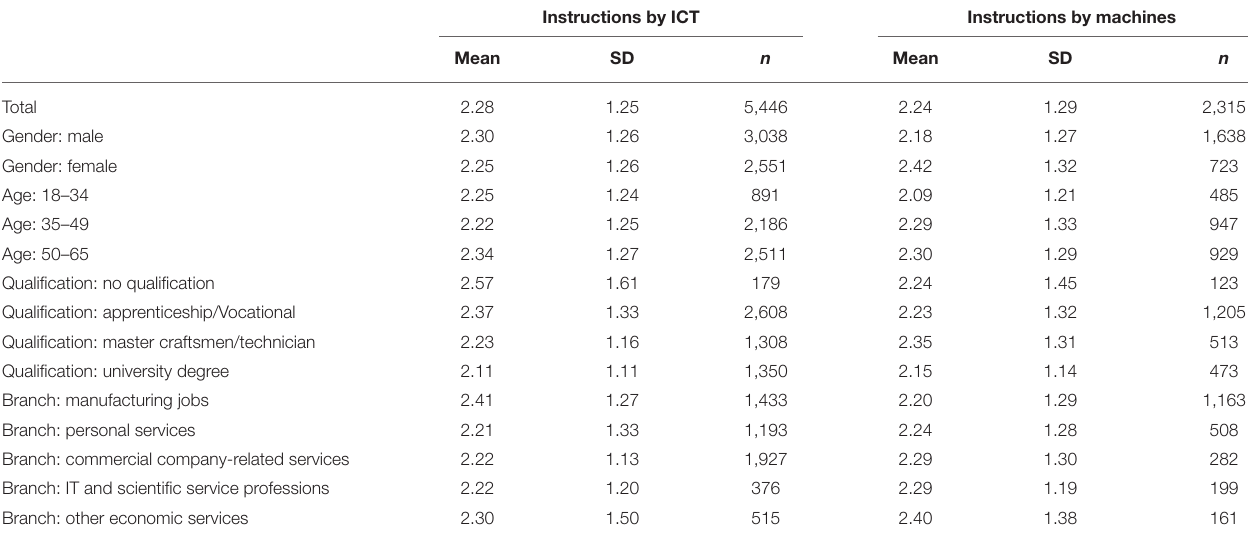
TABLE 2 | Sociodemographics.